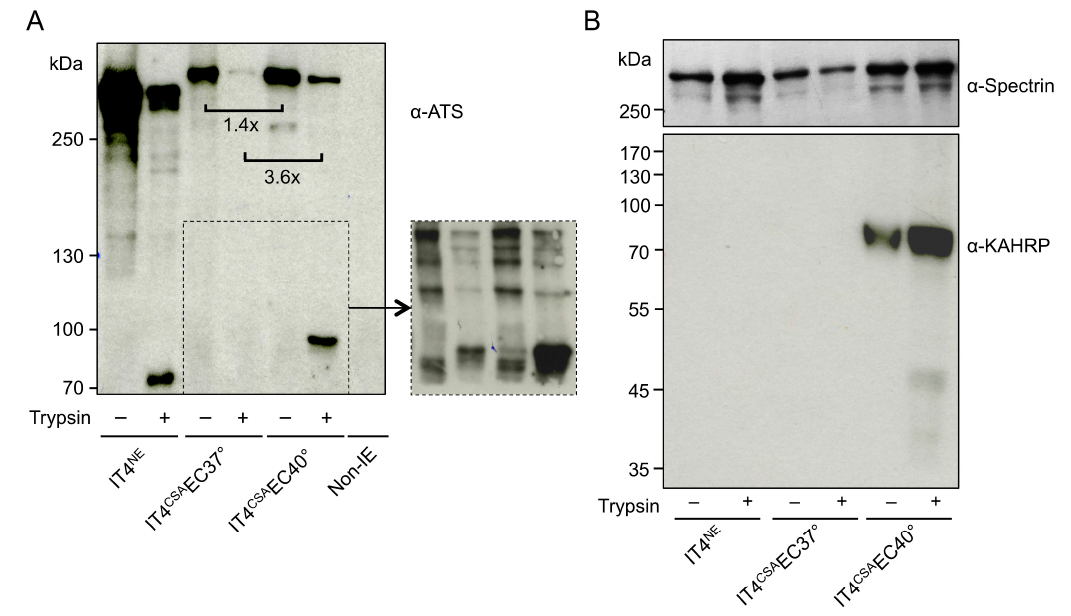
Figure 2. Infected erythrocyte (IE) surface P. falciparum erythrocyte membrane protein 1 ( Pf EMP1) presentation, and knob-associated histidine-rich protein (KAHRP) expression of IT4 populations enriched for binding to HBEC-5i cells at 37 °C and 40 °C. ( A ) Western blot analysis for Pf EMP1 presentation was performed on trypsin-treated or untreated IEs and uninfected erythrocytes using an antibody against the conserved intracellular amino-terminal sequence (ATS) domain of Pf EMP1 molecules ( α -ATS). All samples were solubilized in Laemmli sample buffer, separated by 6% SDS-PAGE and analyzed by immunoblotting. Equivalents of 1 × 10 7 cells were loaded in each lane. The cutout represents a Western Blot with 3-times higher parasite lysate load (3 × 10 7 IEs; Figure S1). Comparison of the relative amounts of protein was normalized to total protein amount using a corresponding Coomassie-stained gel (Figure S2). ( B ) Western blotting for KAHRP was performed with the IE membrane fraction, using α -KAHRP and α -spectrin as controls.